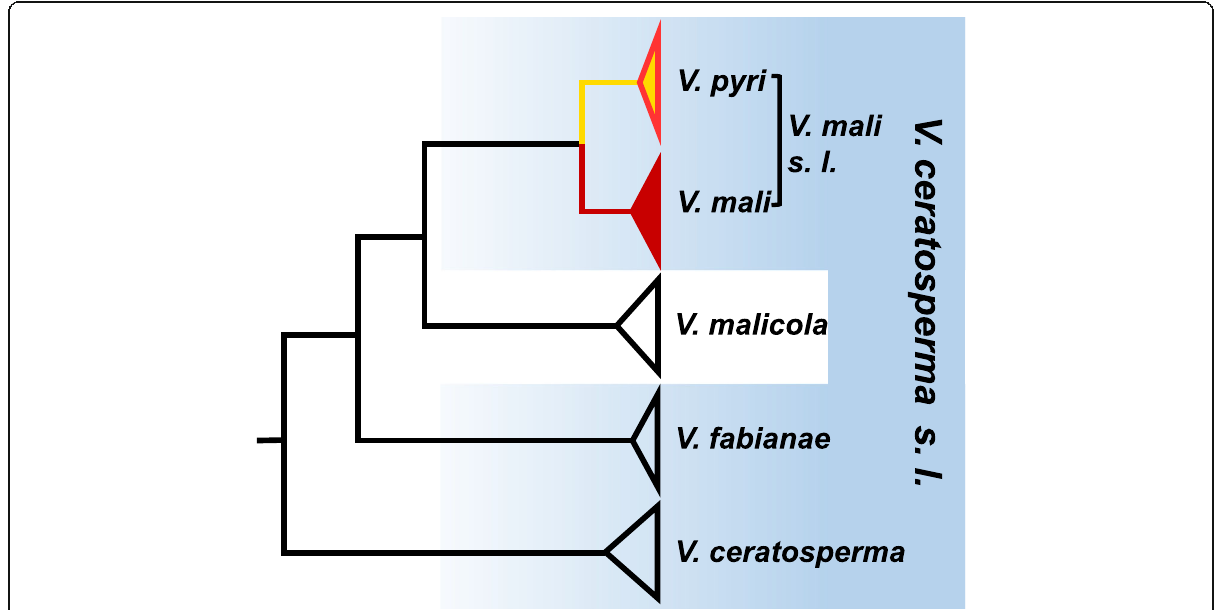
Fig. 1 Phylogenetic relationship among Valsa ceratosperma species complex reconstructed from ITS sequences. V. ceratosperma sensu lato is not a monophyletic group with respect to V. malicola . The lineage of V. ceratosperma sensu Kobayashi (Adams et al. 2005) was recognized as V. mali (Wang et al. 2011, 2014) within which a cryptic species, V. pyri, was further recognized based on multi-gene phylogenetic analysis (Wang et al.